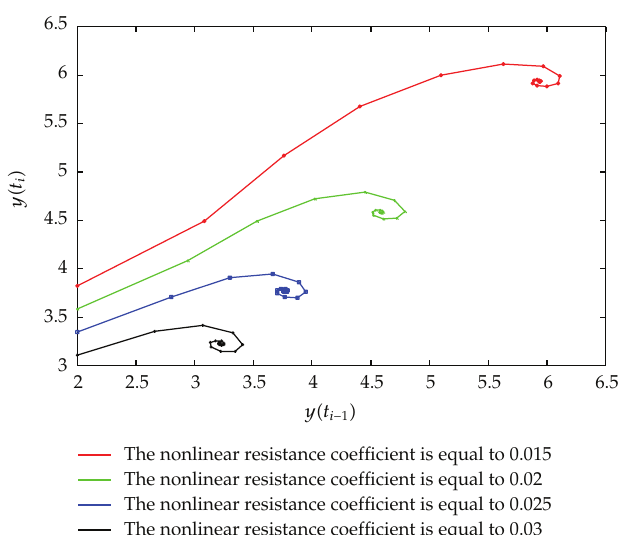
Figure 6: The phase diagram of the process of credit risk contagion where 𝜆 = 0.1 .